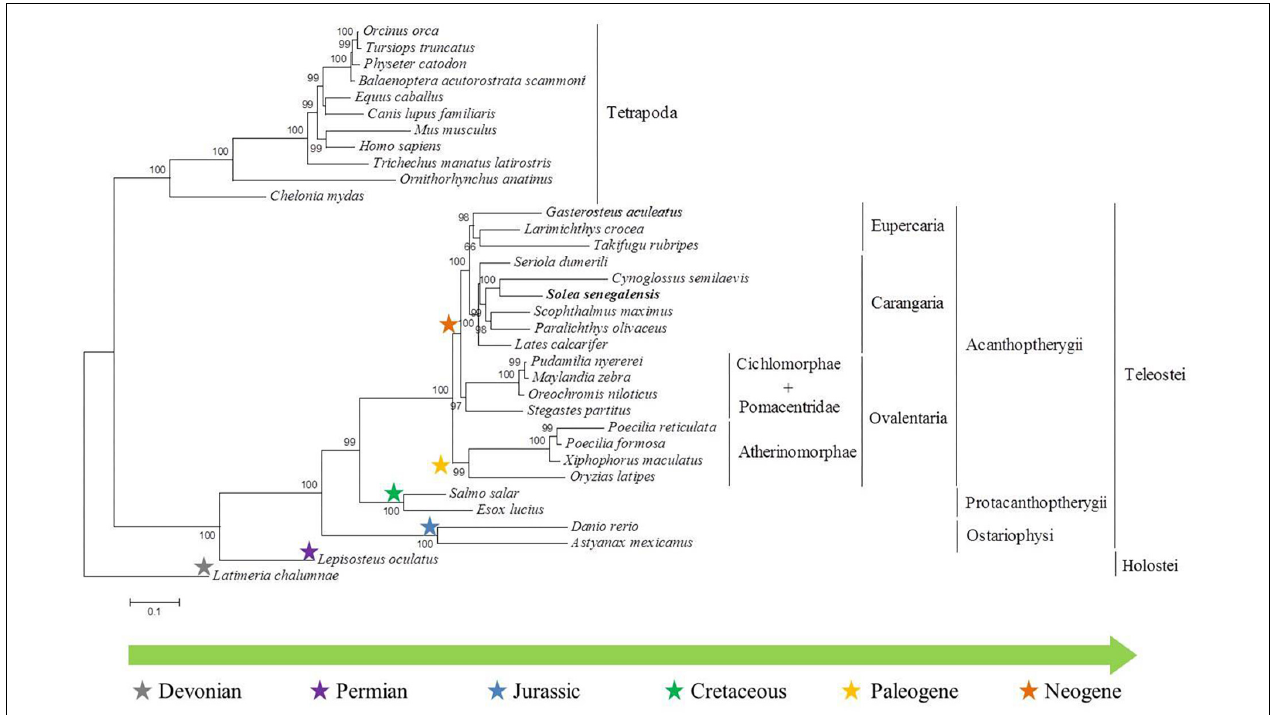
FIGURE 6 | Phylogenetic tree constructed from five immune-system genes ( tlr3, tlr8, nlrc3, calr, ikbke ) of thirty-four different species.